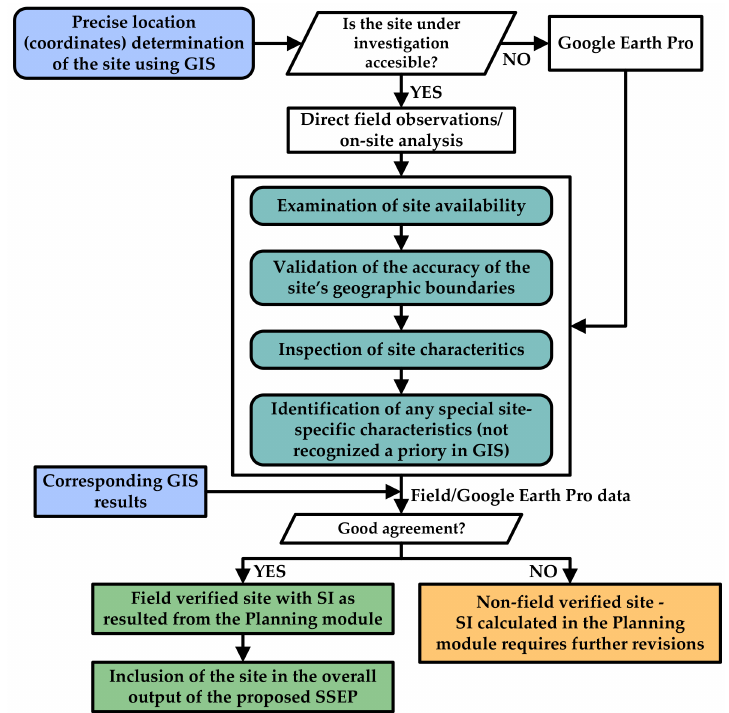
Figure 4. Workflow followed for the realization of the Field Investigation module (Step 6 of the proposed SSEP).